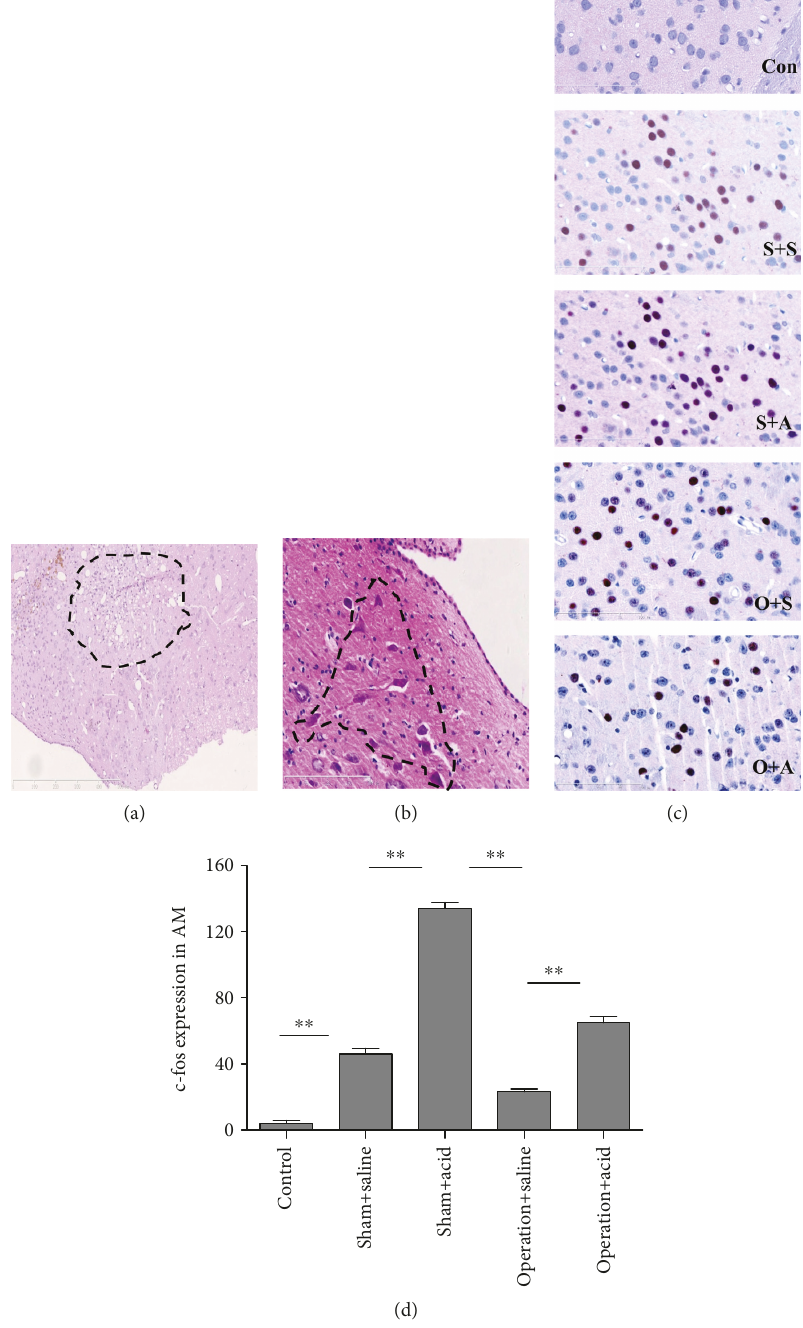
Figure 1: (a) Two weeks after DMV destruction under a light microscope: concurrent with axonal degeneration, myelin was disintegrated, which resulted in lipid and neutral fat, stained red-stained with Sultan III, activated microglia changed into phagocytic cells, necrotic neurons were devoured, bubble cells appeared, astrocytes proliferated, and ultimately honeycomb glial scars appeared. (b) Twenty-four hours after DMV destruction under a light microscope: the nuclei of nerve cells presented with pyknosis, the cells shrank and were deformed, Nissl bodies of the cytoplasm dissolved and disappeared, and then the cells dissolved and disappeared, creating so-called ghost cells that were deeply red-stained by HE. (c) c-fos-positive cells with red nuclei in the AM of all animals. Con: control group ( × 400); S+S: sham + saline group ( × 400); S+A: sham + acid group ( × 400); O+S: operation + saline group ( × 400); O+A: operation + acid group ( × 400). (d) c-fos expression in the AM increased more signi fi cantly in the sham + acid group than in the sham + saline group ( P < 0 01 ). After DMV destruction, c-fos expression more signi fi cantly decreased in the AM in the operation + saline group than in the sham + acid group ( P < 0 01 ). c-fos expression was much higher in the AM in the operation + acid group than in the operation + saline group ( P < 0 01 ) ( n = 8 , ∗∗ P < 0 01